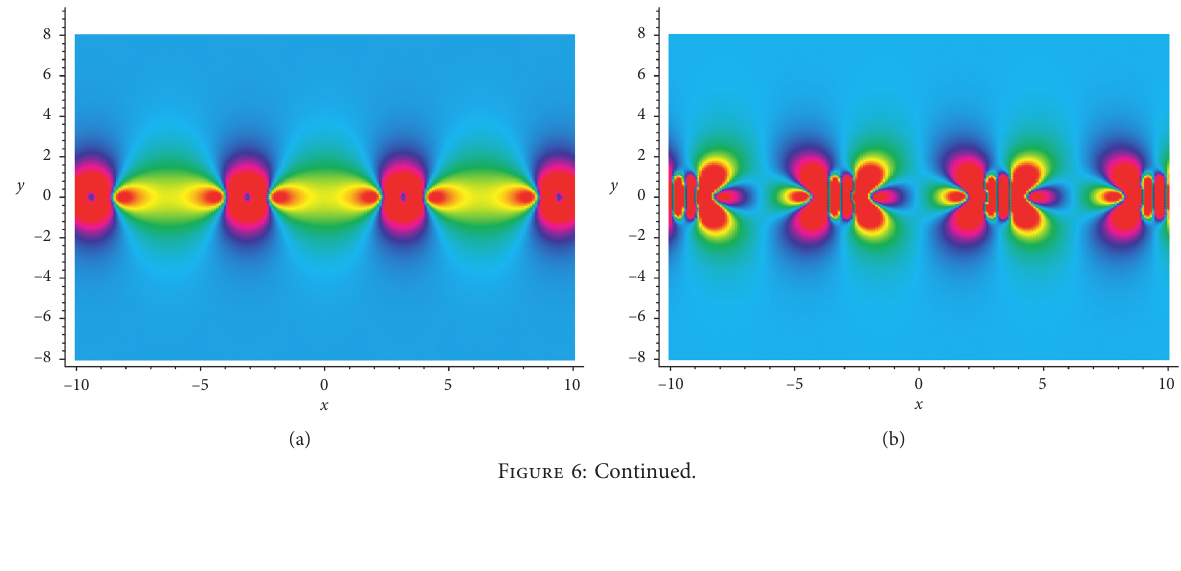
� b � 0 and (b) and (c) b and b are (a) b 1 2 1 2